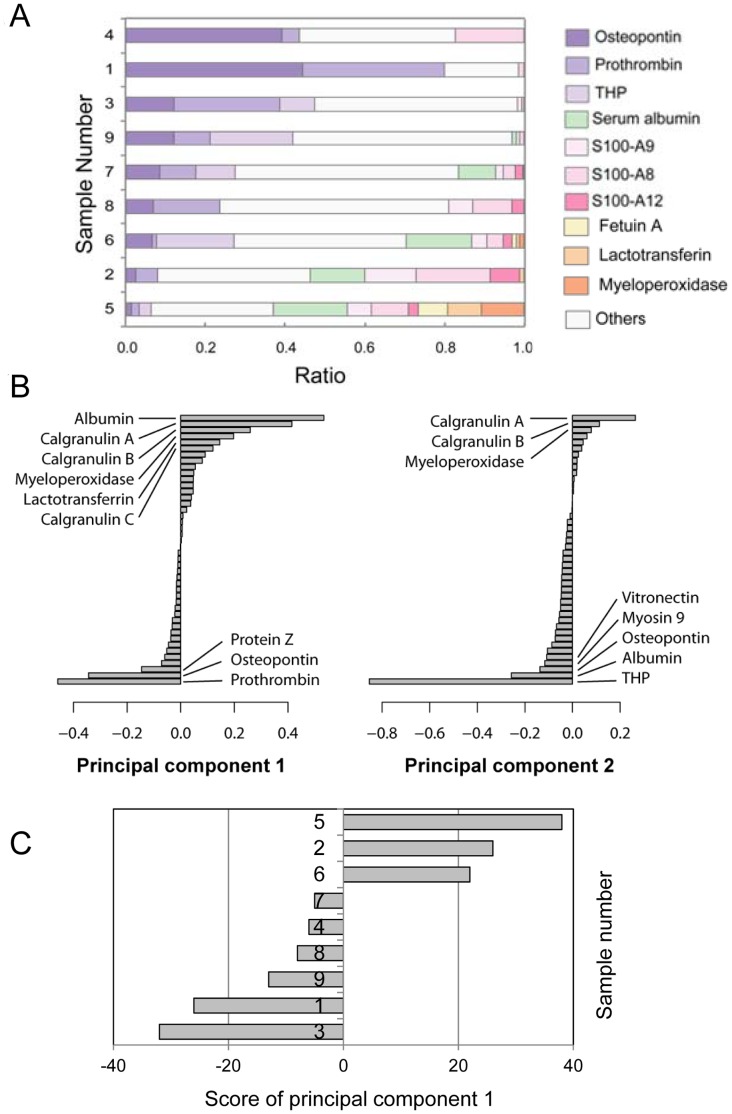
Comparison of relative peptide numbers detected of individual CaOx kidney stones.(A) After nano-LC/MALDI-MS/MS analysis, the numbers of peptide hits were presented as a bar graph with the total number of peptide hits in each gel sample as 100%. (B) The numbers of peptide hits were subjected to principal component analysis, and the first (left) and the second (right) eigenvectors were shown in a decreasing order. (C) The score of principal component 1 of each sample was presented as a bar graph.